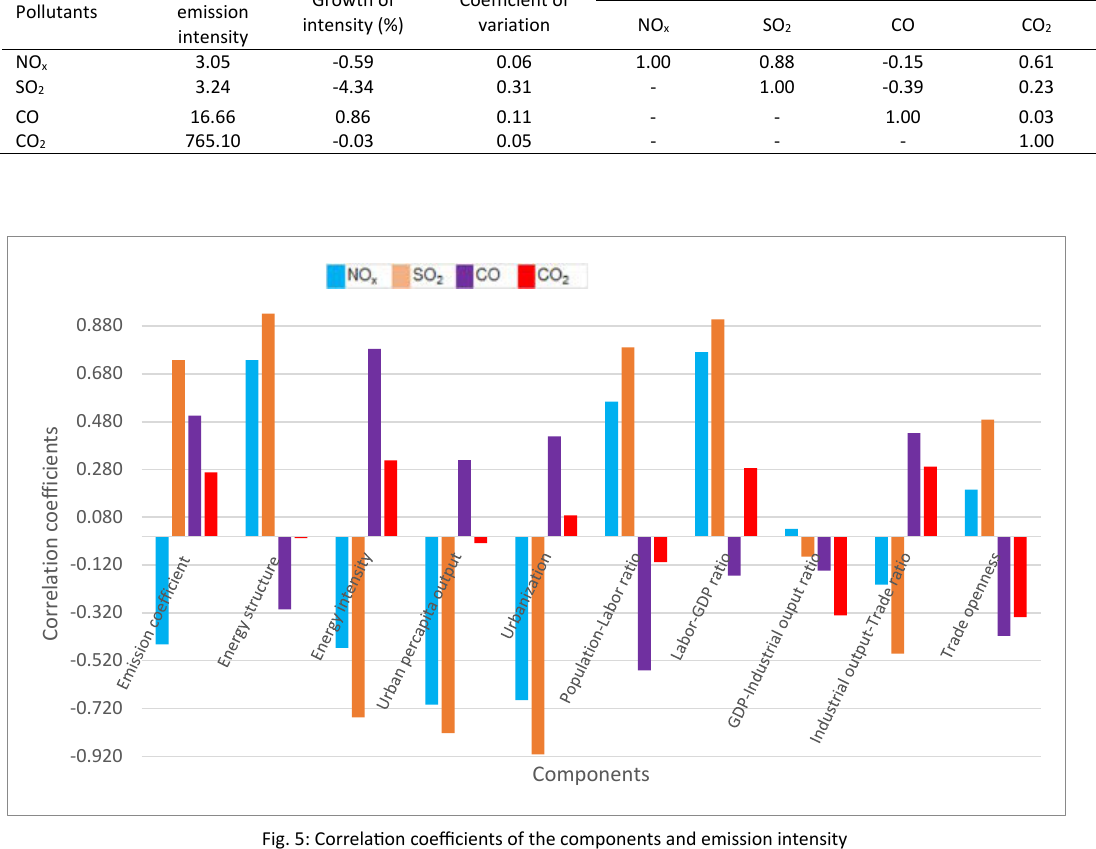
Fig. 5: Correlation coefficients of the components and emission intensity